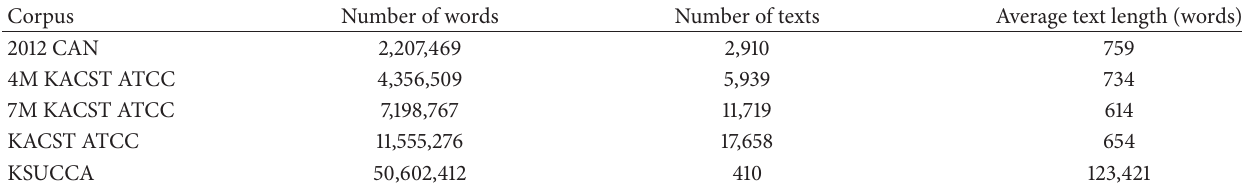
Table 1: Number of words, number of texts, and average text length for the corpora used in the performance evaluation.